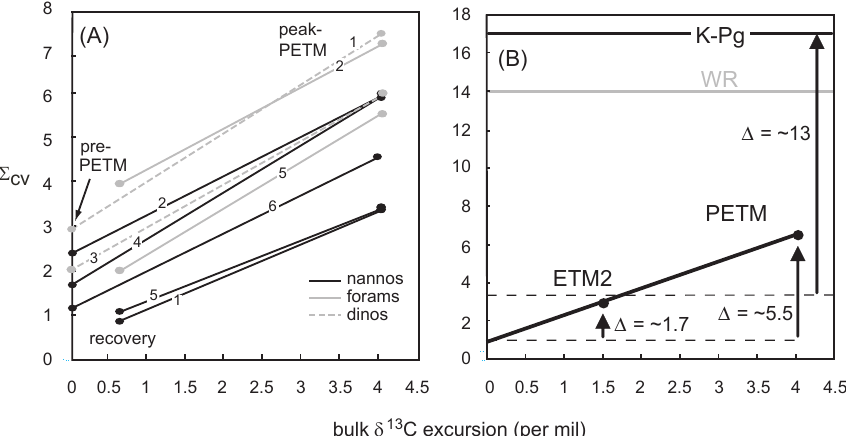
Fig. 5. Scatter plots of summed coefficients of variation ( 6 cv ) against magnitude of CIE for different plankton groups and for comparison with the Cretaceous–Paleogene boundary mass extinction event. Panel (A) shows background and peak PETM 6 cv values for multiple PETM sites – nannofossils (black circles, black lines), planktic foraminifera (grey circles, grey lines) and dinoflagellate cysts (grey circles, grey dashed lines). Where possible pre-event 6 cv values are plotted but where missing, then the 6 cv values from the recovery interval are used. 1 – ODP onshore drill site Bass River (nannofossils (Gibbs et al., 2010) and dinocysts (Sluijs and Brinkhuis, 2009)); 2 – ODP Site 690, Southern Ocean (nannofossils (Bralower, 2002) and planktic foraminifera (Kelly, 2002)); 3 – Lomonosov Ridge, Arctic Ocean (dinocysts (Sluijs et al., 2008)); 4 – TDP, Tanzanian drilling project Site 14 (nannofossils (Bown and Pearson, 2009)); 5 – ODP Site 1209 (nannofossils – herein – and planktic foraminifera (Petrizzo, 2007)); 6 – ODP Site 1260, Demerara Rise, Atlantic Ocean (nannofossils (Mutterlose et al., 2007)). All 6 cv data use 10 taxa for comparison or, for the foraminifera data, normalised to 10 taxa. Panel (B) illustrates the 16 cv of the PETM and ETM2 from Site 1209 compared with the K-Pg using data from Site 1210 (horizontal black line (Bown, 2005)) and Site 1262 (WR – Walvis Ridge, horizontal grey line (Bernaola and Monechi, 2007)). The K-Pg 6 cv value is not plotted against its respective δ 13 C value as this is not a meaningful measure of environmental perturbation for this